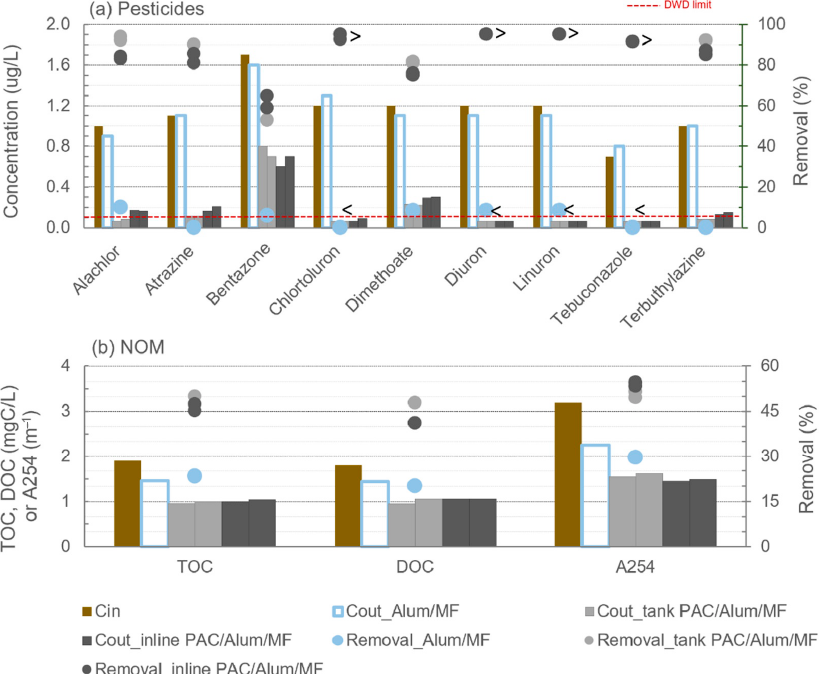
Figure 4. Pesticides’ concentrations ( a ) and NOM content ( b ) in trial 2: intake (W2) and concentrations (bars) and removals (circles) after Alum/MF or PAC/Alum/MF with 12 mg/L inline PAC dosing or 8 mg/L PAC dosing to tank (“<” represents concentrations below LOQ and “>”removals computed with LOQ; doted red line is the Drinking Water Directive limit for pesticides).